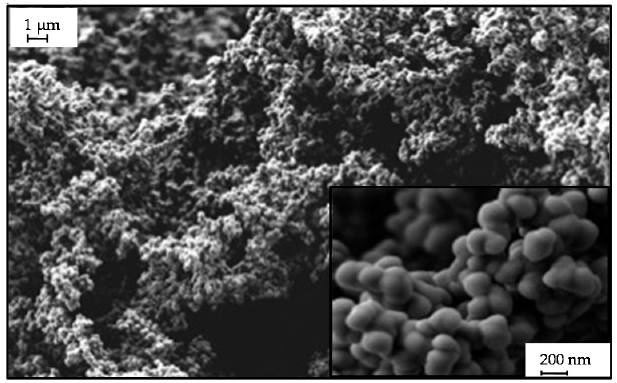
Figure 3. Microstructure of sf-RF aerogel with particles of about 0.12 µm and an average pore size of about 1.8 µm.